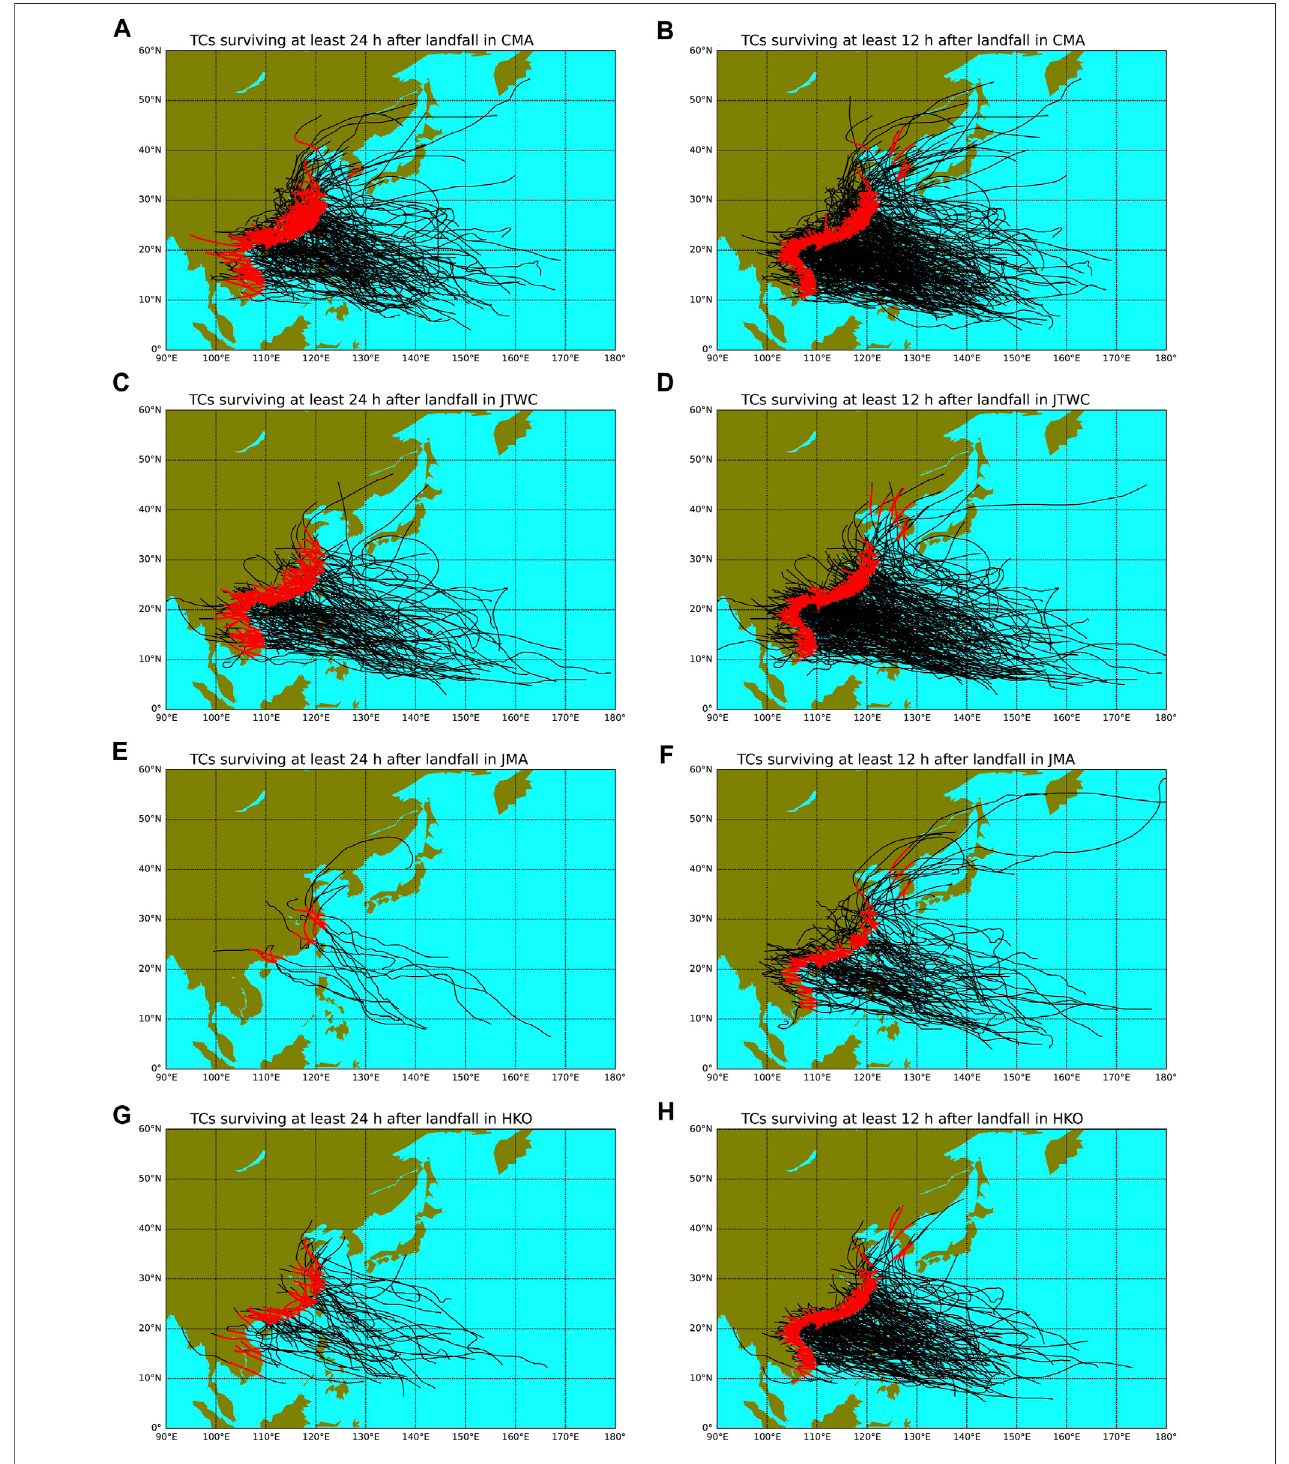
FIGURE1| TracksoflandfallingWNPTCsidenti fi edfromthe (A,B) CMA (C,D) JTWC (E,F) JMAand (G,H) HKOdatasetfrom1966to2018.Thetrajectoriesduring the fi rst 24 and 12 h after landfall are represented as red thick lines in the left and right columns, respectively.